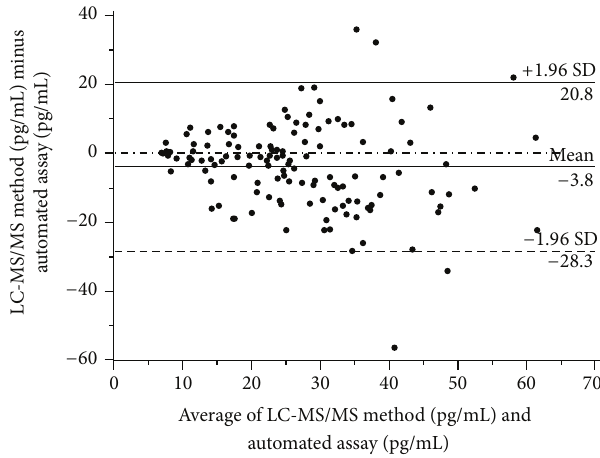
Figure 4: Bland-Altman plot showing the bias between the auto- mated method and the mean of the two methods.